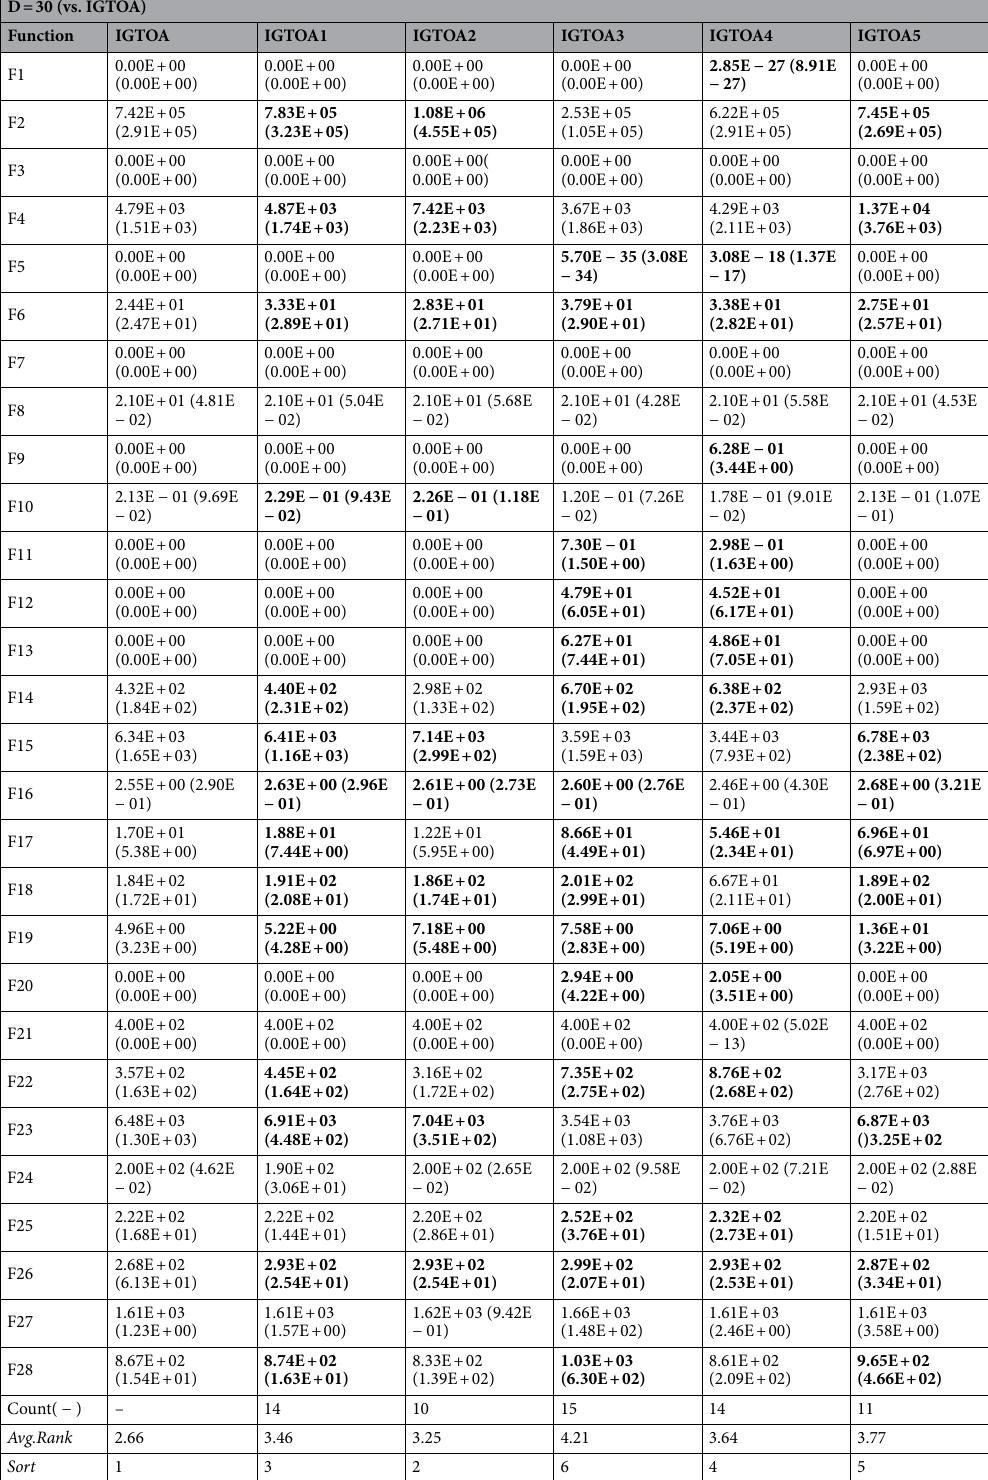
Table 3. Comparison results of each improvement strategy with IGTOA on the 30-dimensional CEC2013 test suite. Note: The parameters that perform best on each function are